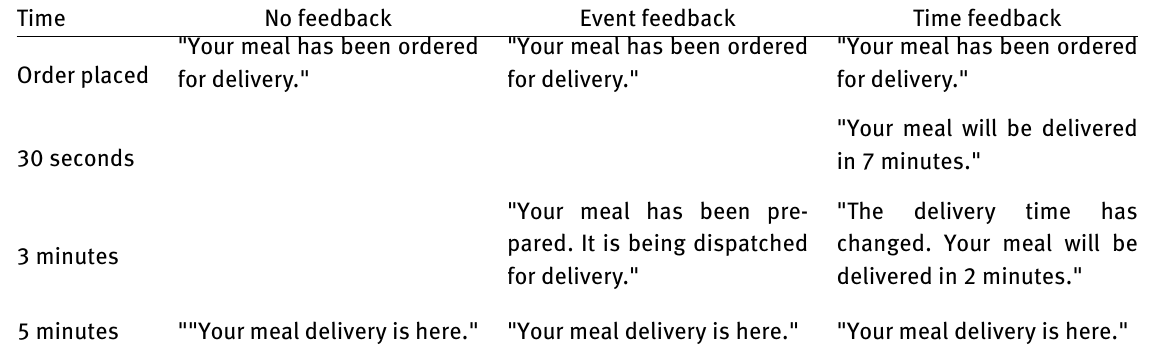
Table 1: Timeline of robot speech acts for each experimental condition. Time No feedback Event feedback Time feedback "Your meal has been ordered "Your meal has been Order placed for delivery."